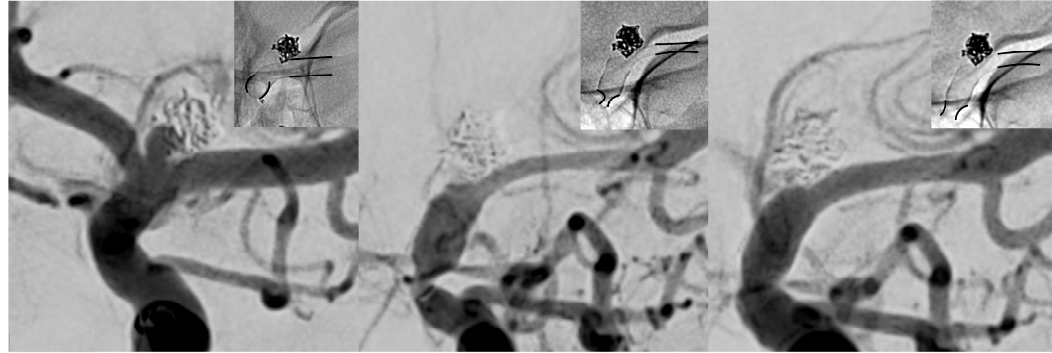
Figure 1. Subsequent imaging findings of the symptomatic patient from uneventful implantation ( left ), to clinically manifest vasospasm (middle, three weeks post procedure) and after the first session of intra-arterial (i.a.) treatment ( right ). Note the change in caliber of the proximal and distal landing zones (black lines in each radiogram underline the change of caliber of the implanted flow-diverting stent (FDS)). The left image demonstrates normal calibers of vessel and implanted FDS approximately 30 min after the procedure. The middle image reveals high-grade tandem stenosis of the terminal internal carotid artery (ICA) and the M1 segment, caused by subacute vasospasm resulting in severe stent compression. The right image shows a significant increase in caliber immediately after i.a. spasmolysis, accompanied by clinical recovery of the